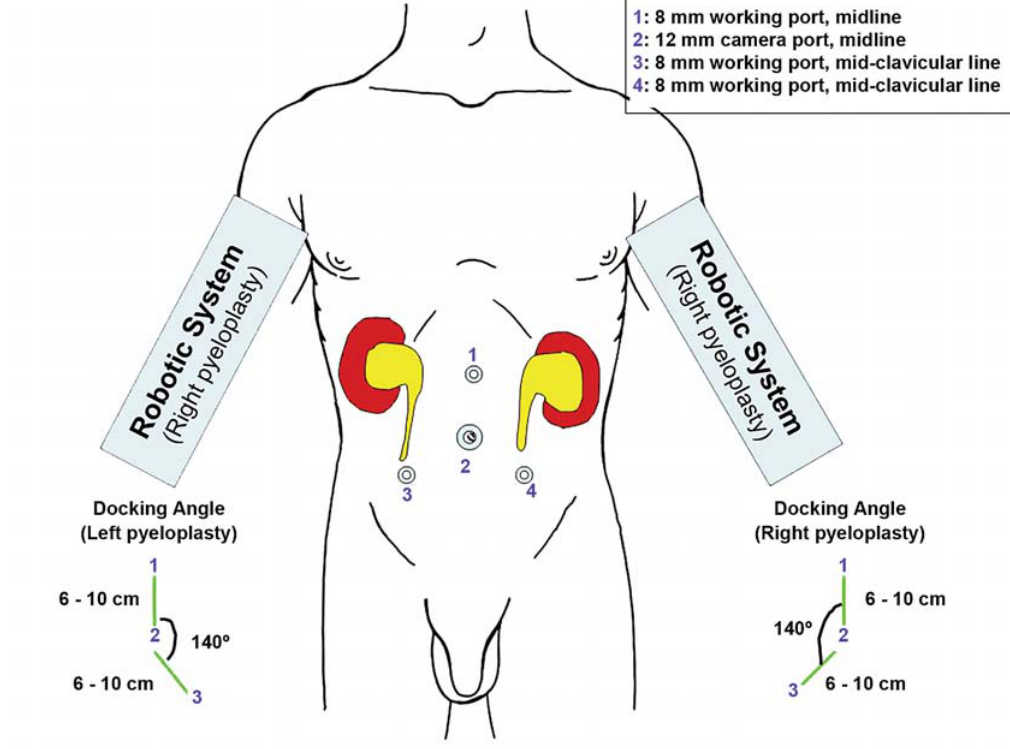
Figure 1 – Surgical cart and port placement.